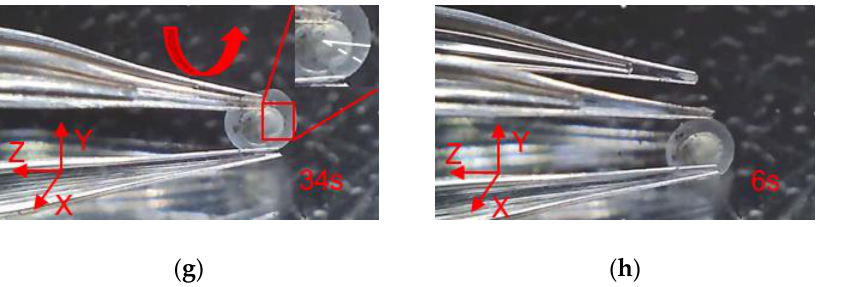
Figure 17. Manipulation of a embryo: ( a ) Initial state; ( b ) Microgripper is moved to approach the embryo; ( c ) The microgripper is moved downward to approach the embryo; ( d ) The microgripper is reached to the clamping position; ( e ) The embryo is clamped; ( f ) The embryo is move upward; ( g ) The embryo is rotated about axis Z; ( h ) The embryo is released.